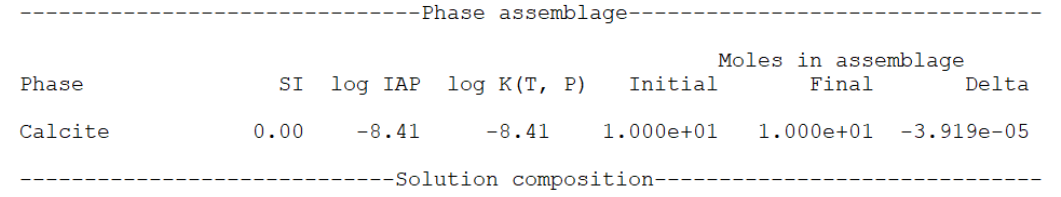
Figure A2. Excerpt from the PHREEQC output file.